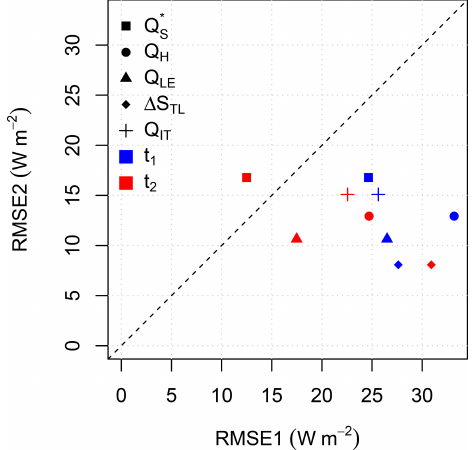
Figure B1. Investigating differences between surface energy fluxes at PLD (paleolake delta) and GT (glacial till), both belonging to NWT (non-water track reference stations), via comparison of two statistical estimates using mean diurnal variations and based on root-mean-squared errors (RMSE): RMSE1 quantifies differences between WT (water track) and NWT separately for recording peri- ods of PLD ( t 1 ) and GT ( t 2 ). RMSE2 computes disparity of PLD and GT, cleared of the influence of meteorological boundary condi- tions, calculated as the change from t 1 to t 2 of differences between WT and NWT. Computation of RMSE1 and RMSE2 for net radi- ation ( Q ∗ ), sensible heat flux ( Q H ), latent evaporative heat flux S ( Q LE ), heat storage change in the thawed layer ( (cid:49)S TL ), and soil heat flux at ice table depth ( Q IT